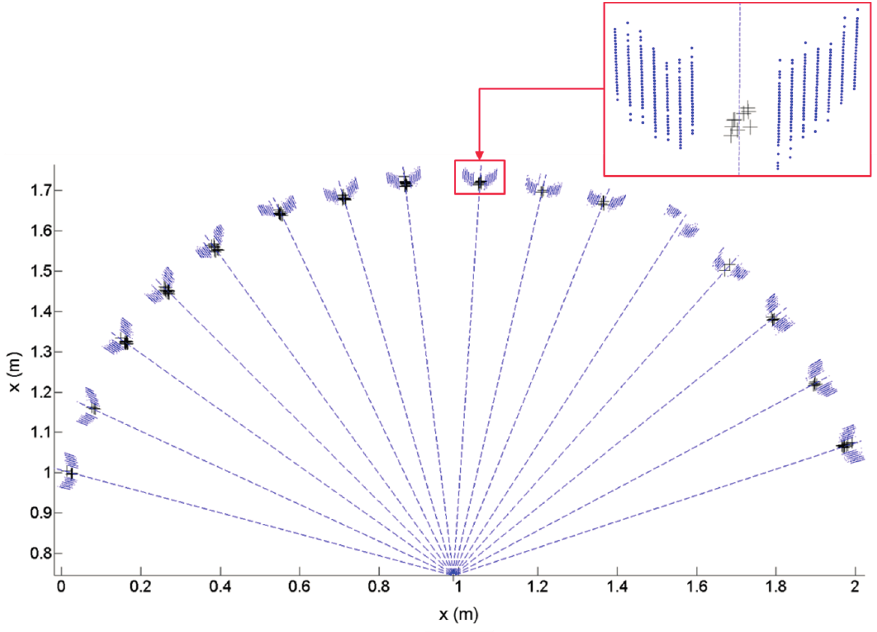
Figure 14. Estimation of the horizontal target centers by laser